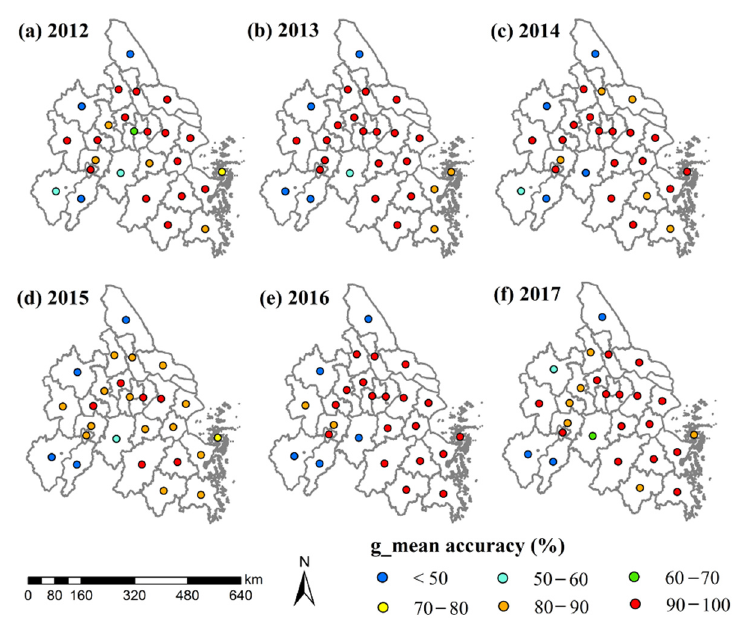
Figure 2. Geometric mean accuracy for urban area extraction in the YRD.